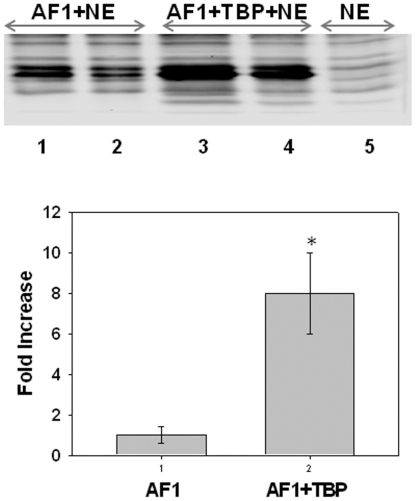
TBP-binding induced conformation in AF1 facilitates AF1's interaction with SRC-1.Immuno-reaction to anti-AF1 antibody after immunoprecipitation (IP) from HeLa nuclear extracts (NE) with SRC-1 antibody (Upper Panel). Lanes 1&2, AF1+NE+beads; Lanes 3&4, AF1+TBPC+NE+beads; Lane 5, NE+beads (negative control). An average densitometric analysis of band intensity showing relative fold induction (*p>0.05) (Lower Panel).